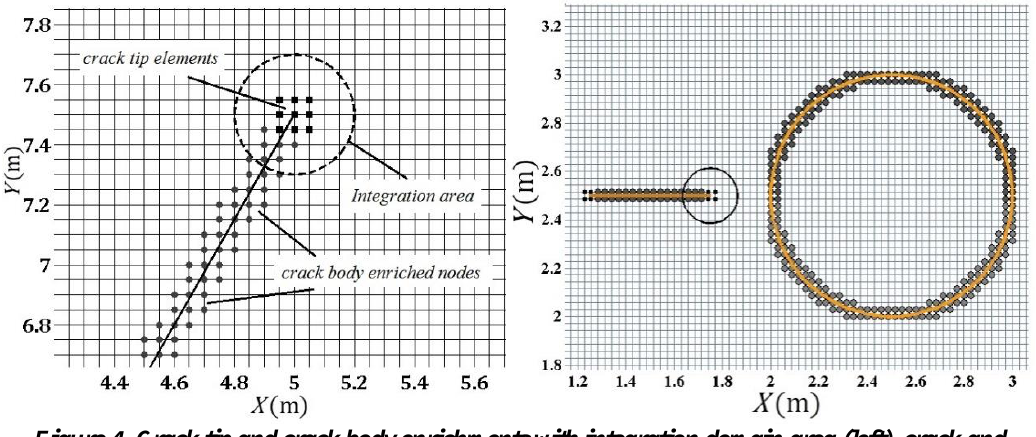
Figure 4. Crack tip and crack body enrichments with integration domain area (left), crack and inclusion enrichments